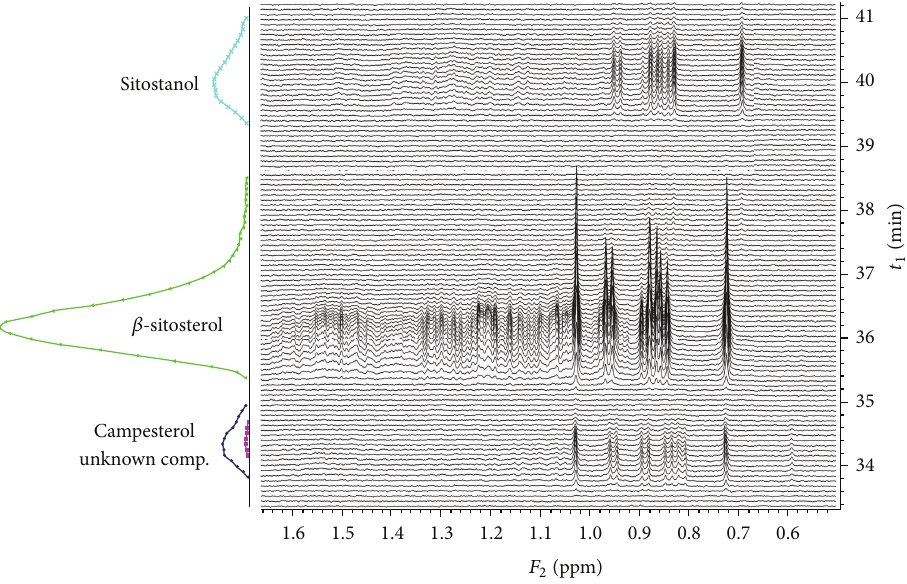
Figure 3: On-flow HPLC-NMR measurement of technical 𝛽 -sitosterol and its quantitative